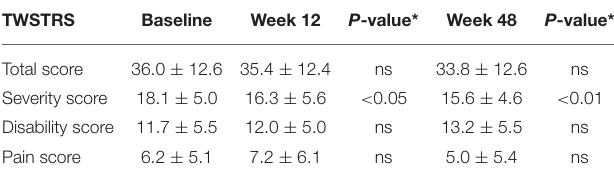
TABLE 1 | Mean ( ± SD ) TWSTRS scores at week 12 and 48 of the study period. TWSTRS